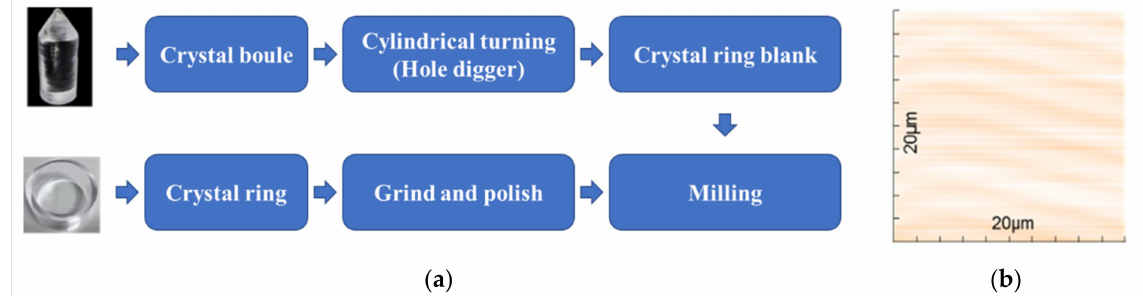
Figure 3. ( a ) The procedures used to fabricate the detector. A hollow crystal ring is daggered from a crystal boule with two diggers of different diameters. The hollow ring is then milled and polished using a polyurethane polishing pad and CeO 2 polishing solution. ( b ) AFM map of top surface of the ring.